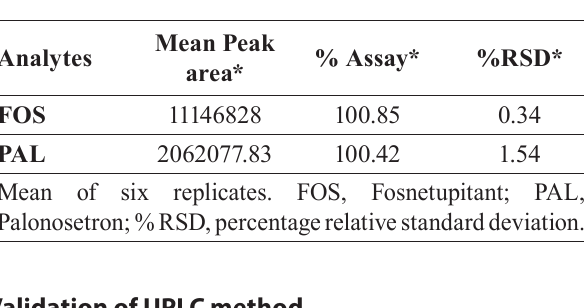
Table II - Analysis of